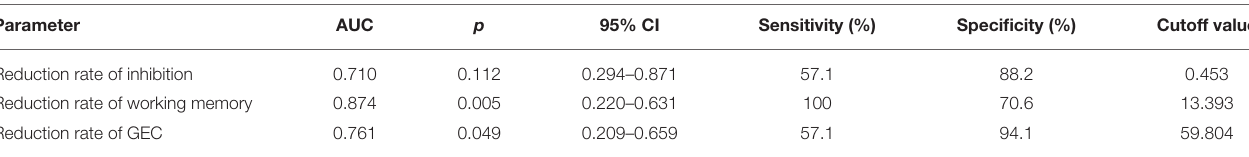
TABLE 6 | ROC curve analysis for predictive power of reduction rates of inhibition, working memory, and GEC to iTBS therapeutic efficacy.